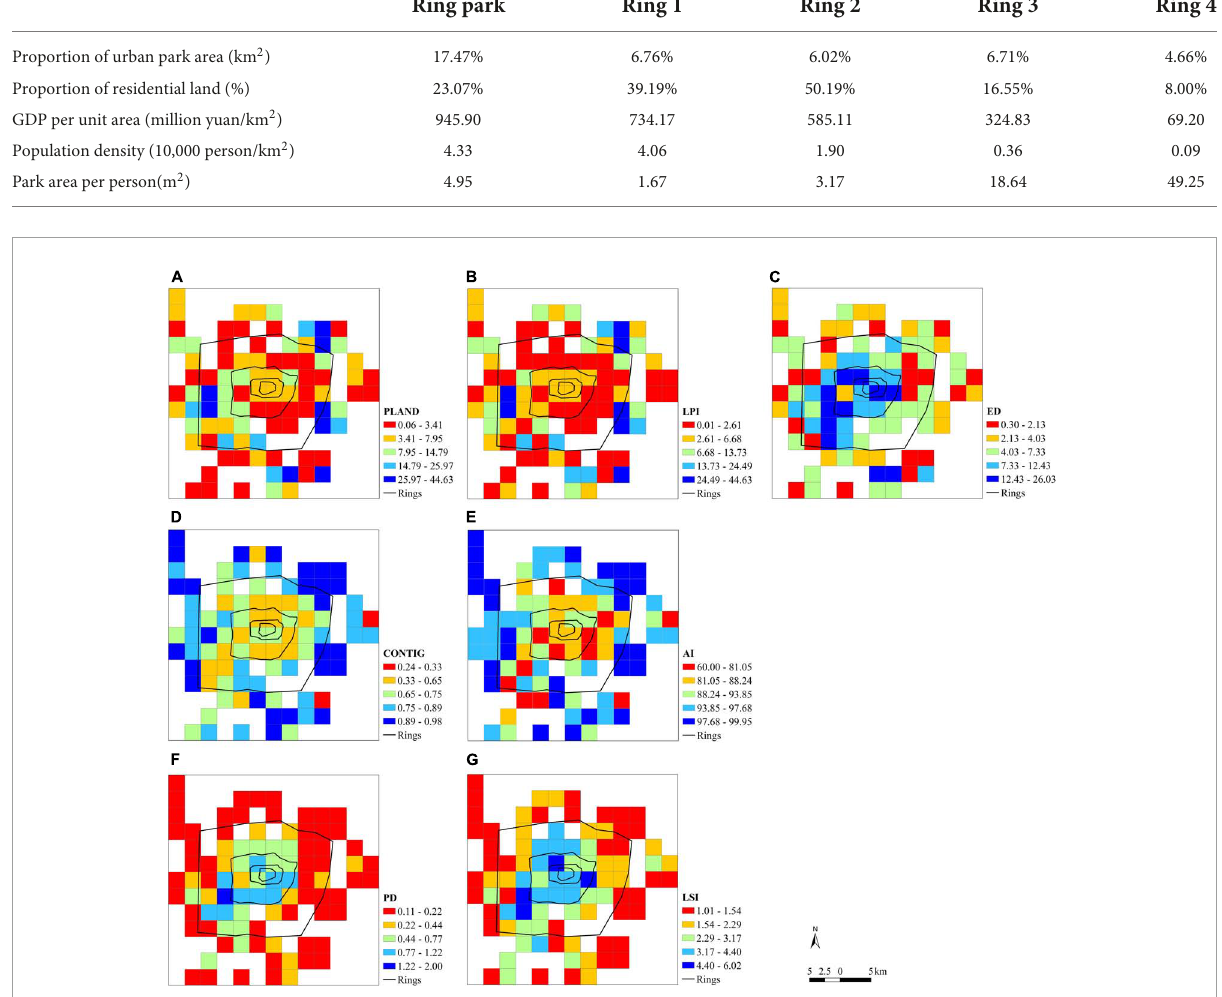
FIGURE10 Spatial distribution of parks landscape metrics. (A–G) PLAND, LPI, ED, CONTIG, AI, PD, and LSI,